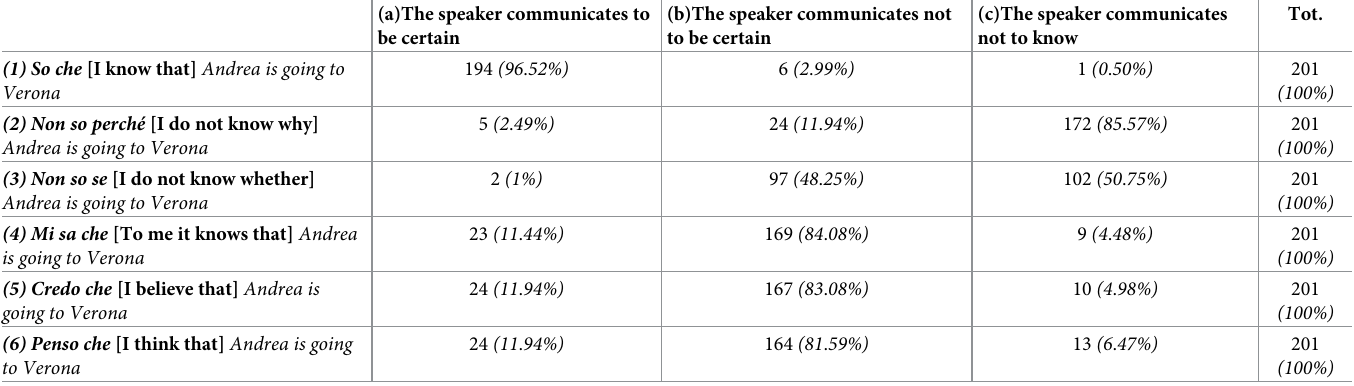
Table 2. Numbers and percentages of participants who chose which EMPs for which